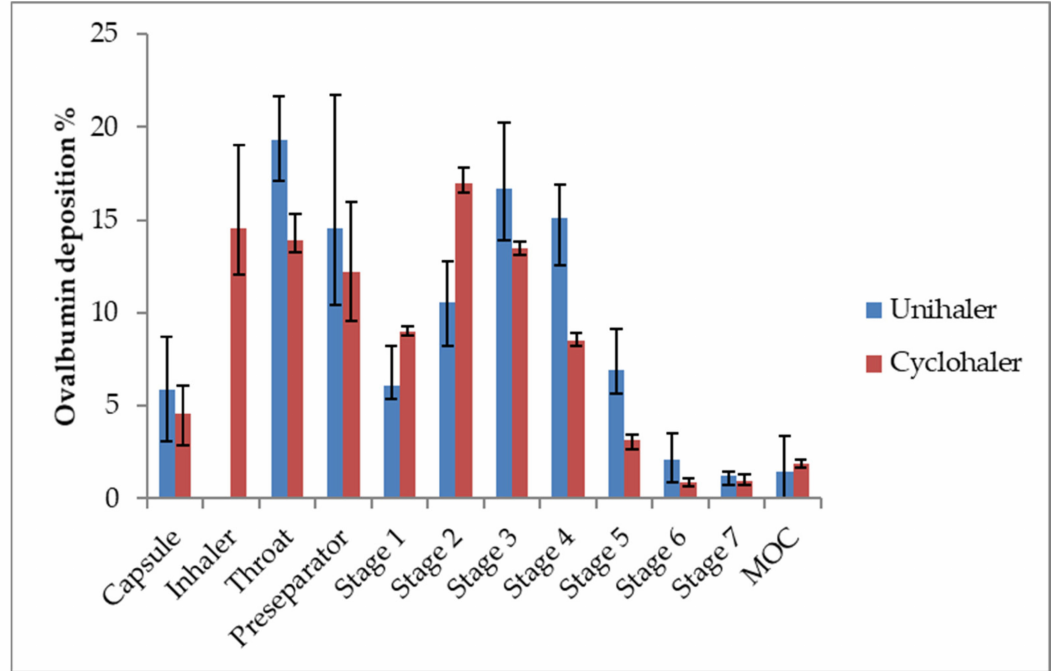
Figure 6. Deposition profile of the NGI of spray dried powder with nanoparticles prepared via double emulsion technique dispersed from the Cyclohaler (red) or the Unihaler (blue) device. n = 3, error bars show min–max.